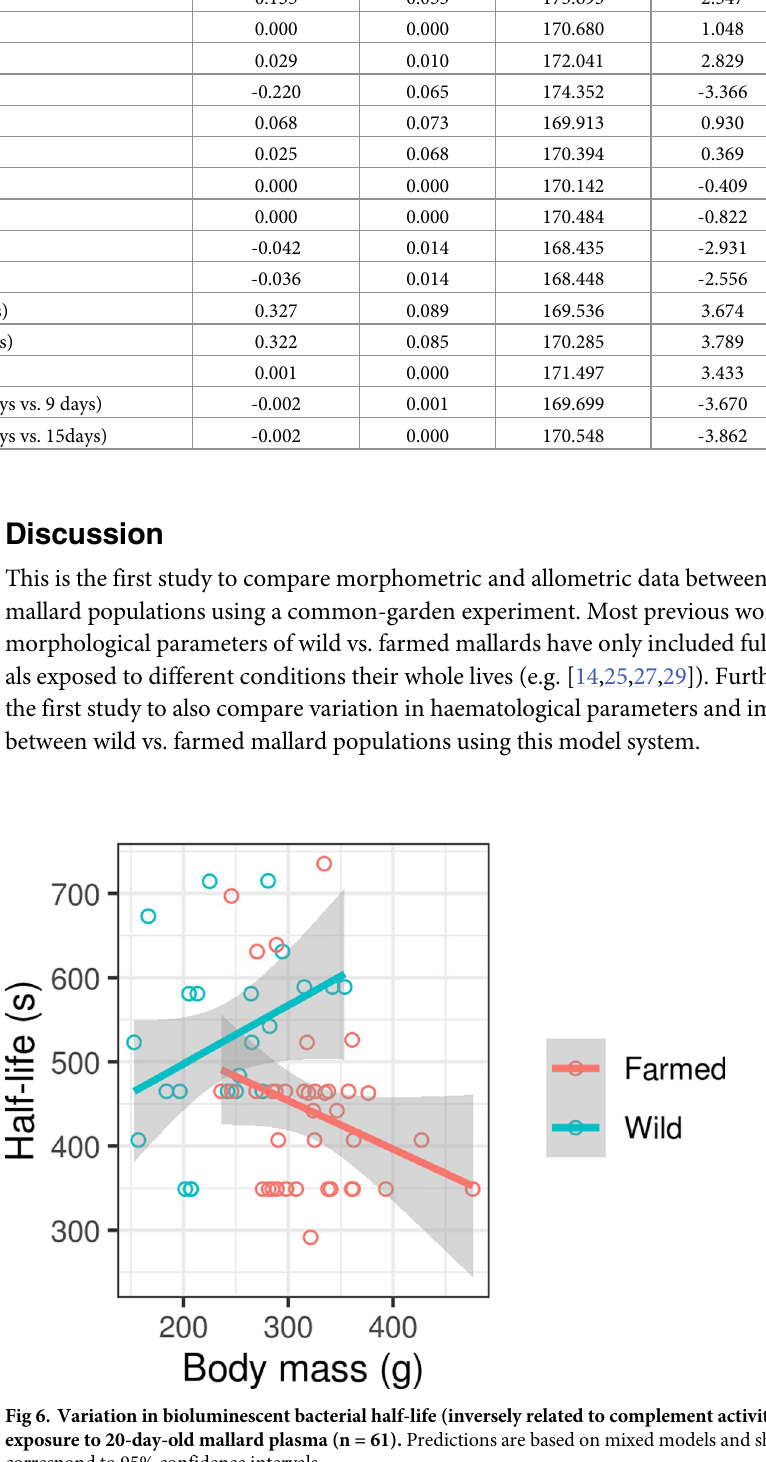
Table 3. Parameter estimates for the minimal adequate model for proportion of immature erythrocytes (n wild = 24, n farmed = 40). Predictor